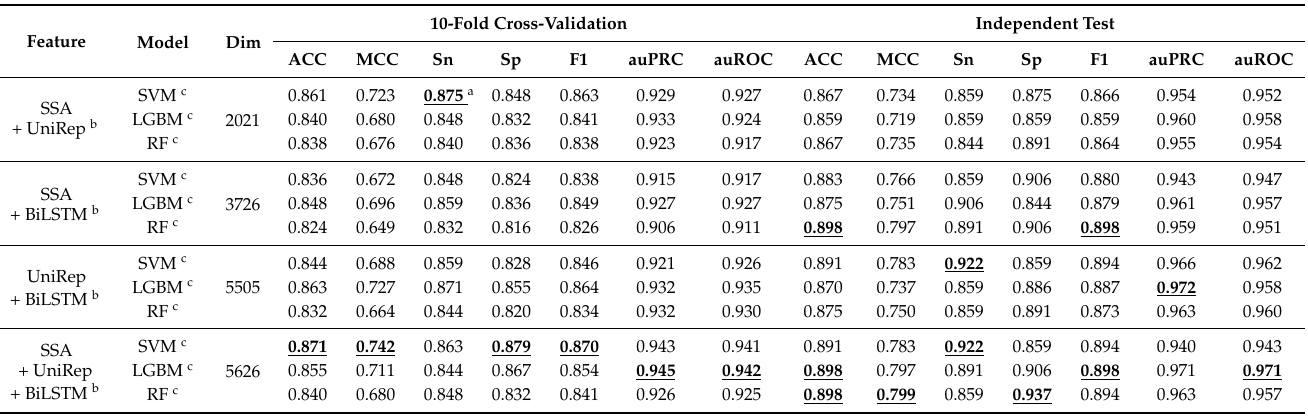
Table 2. Performance metrics of fusion features developed using three machine learning models in 10-fold cross-validation and in independent tests.